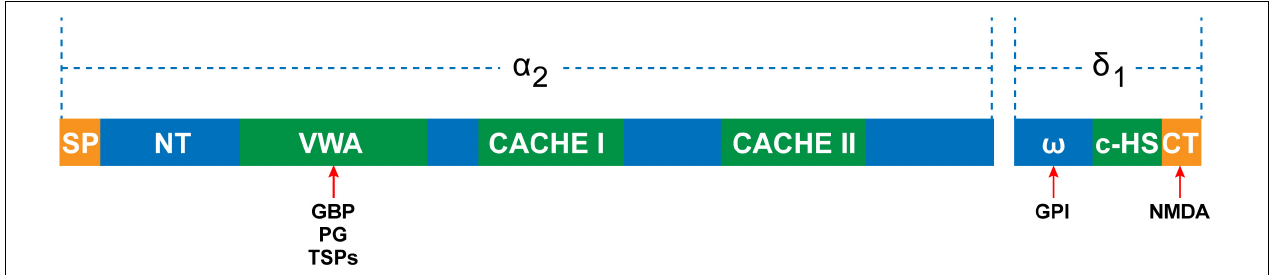
FIGURE 2 | The domain structure of the α 2 δ 1 subunit. The α 2 peptide contains N-terminal domain, VWA domain, and two extracellular domains (CACHE I and II). The VWA domain is the potential binding site for gabapentin (GBP), pregabalin (PG), and thrombospondins (TSPs). The δ peptide contains ω amino acids, to which the glycosyl-phosphatidylinositol (GPI) anchor can attach, C-terminal hydrophobic sequence (c-HS), and C-terminal, which is the NMDA binding site.